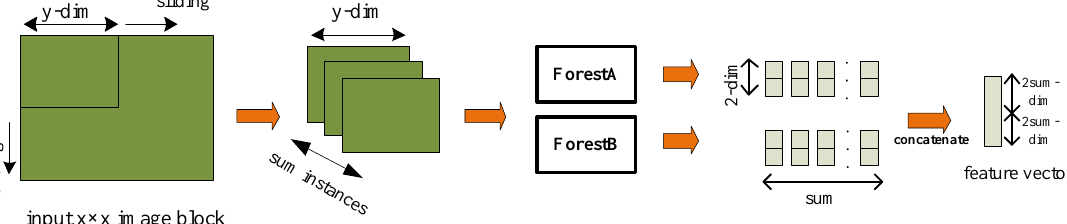
Figure 1. Illustration of feature re-representation using sliding window scanning, supposing there are two classes to predict and each forest will output a two-dimensional class